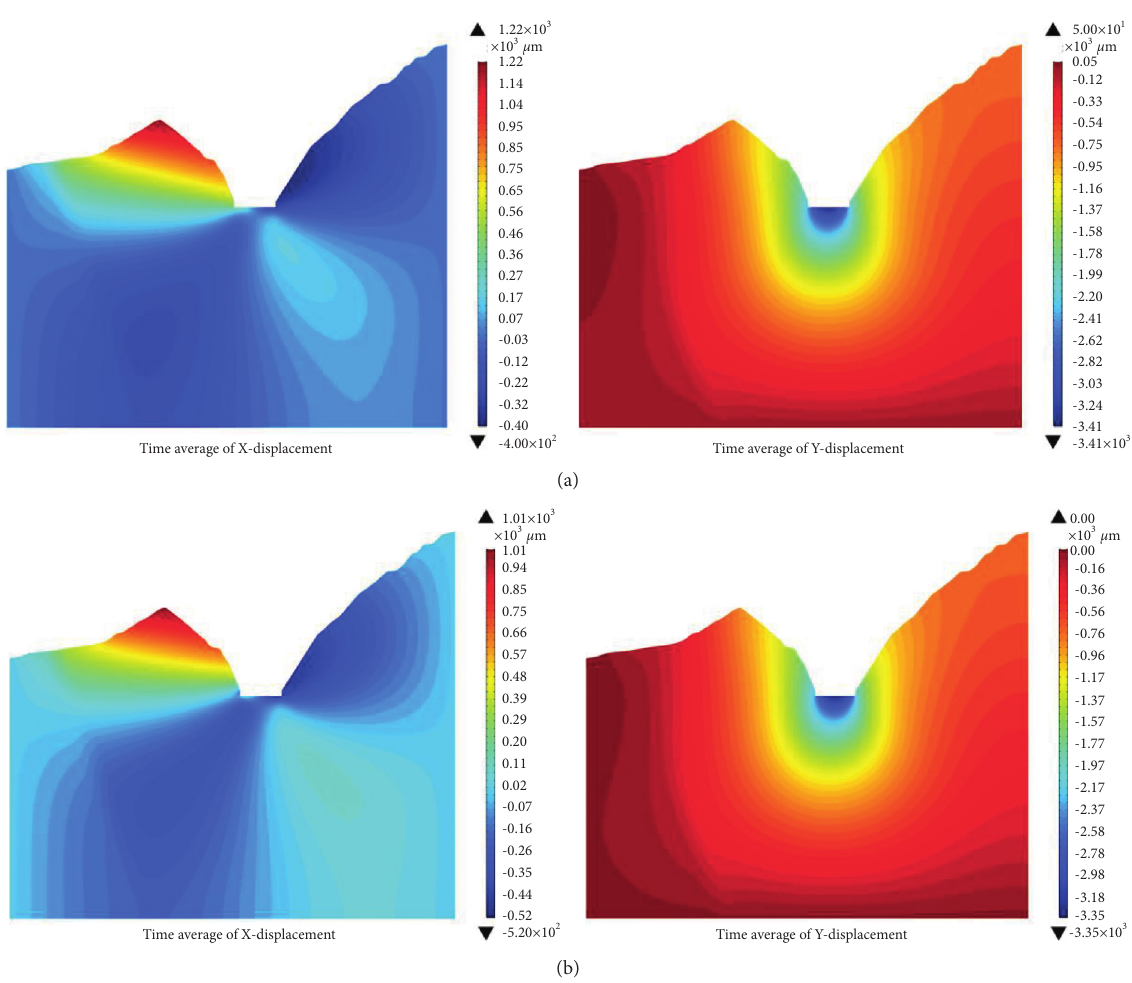
Figure 8: Time average of displacement.